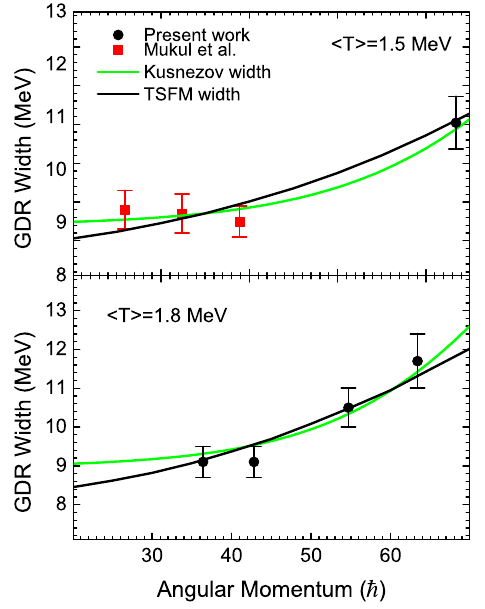
Figure 3. GDR width as a function of average angular mo- mentum for di ff erent average temperature bins. Red squares are widths from previous measurement [3] and black circles repre- sent present experimental data. Solid lines are theoretical cal- culations for di ff erent T values using TSFM calculations (black line) and Kusnezov’s parametrization (green